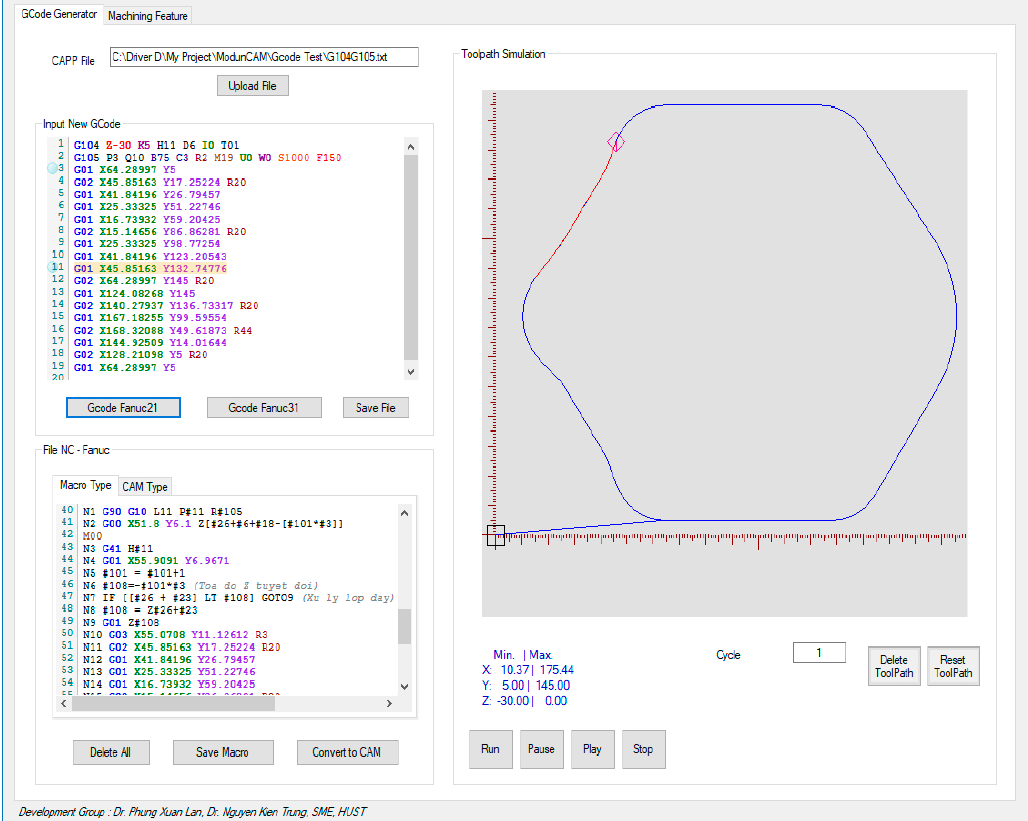
Figure 7. The interface of the G-code generation module.